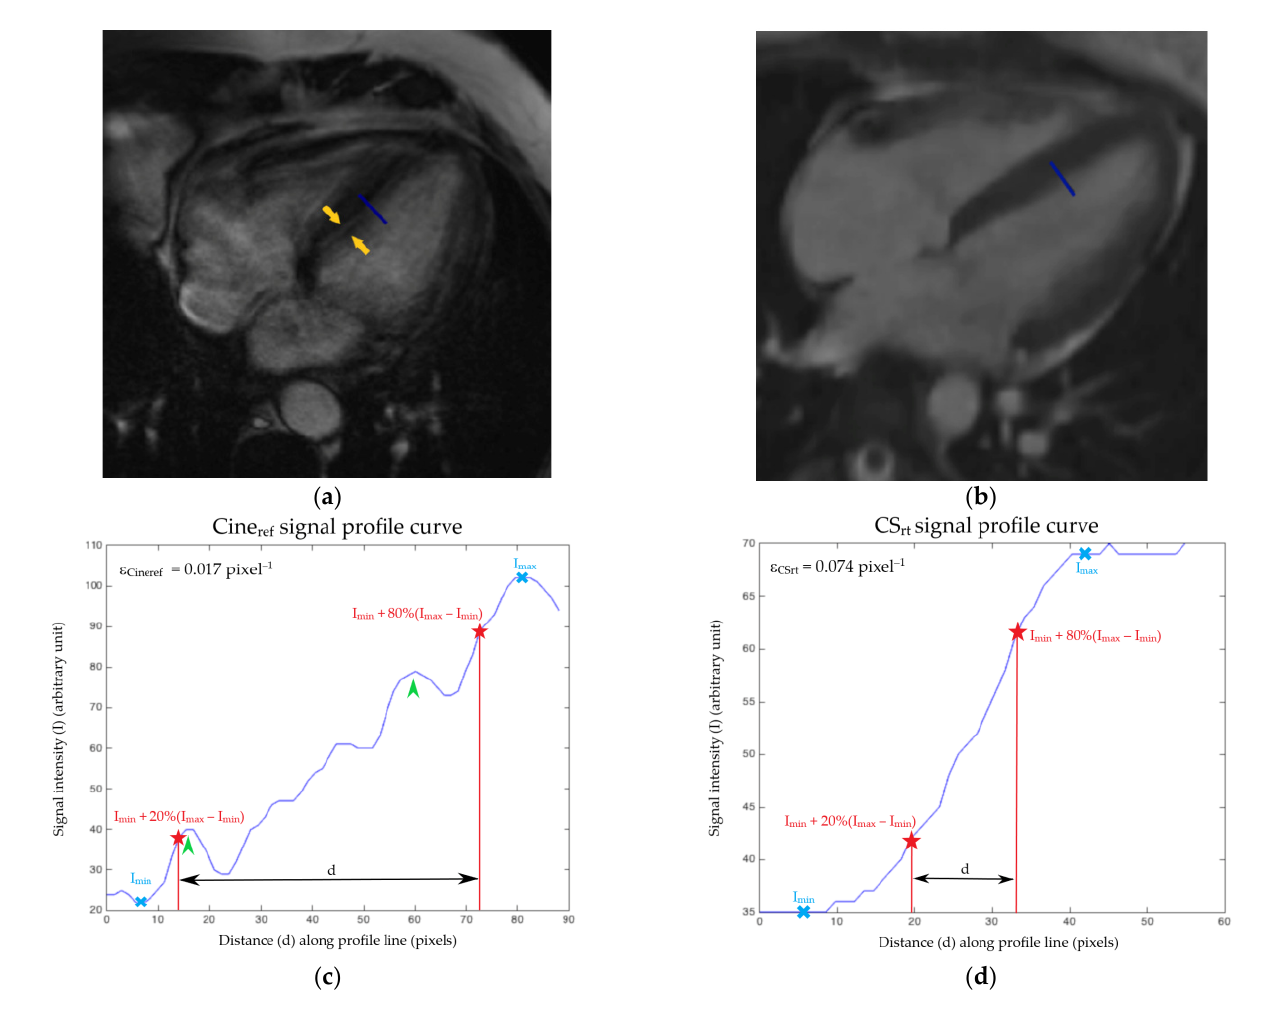
Figure 1. Example of edge sharpness assessment at end-diastole for a 56-year-old male patient suffering from atrial fibrillation. The same four-chamber view at end-diastole is acquired with ( a ) the Cine ref sequence and ( b ) the CS rt sequence. An orthogonal profile line was drawn at mid-cavity across the border between the septal myocardium and the left ventricular blood pool (blue line) on a four-chamber view. It provided intensity profiles (blue curves) along the line for ( c ) Cine ref and ( d ) CS rt cine. The edge sharpness was the inverse of the distance d (in pixels) between the positions corresponding to 20% and 80% (red stars) of the difference between the maximum and minimum signal intensities (blue crosses). The edge sharpness was expressed in pixel − 1 . This measurement was performed at end-diastole and end-systole for both sequences. Note that the peaks (arrows heads) added to the Cine ref signal profile curve ( c ) correspond to the doubling of the interventricular septum border (arrows) on the cine view ( a ). The same assessment was performed on both sequences at end-diastole and end-systole for the 71 enrolled patients. Abbreviations: Cine ref , reference segmented cine; CS rt , real-time compressed sensing cine; ε Cineref , edge sharpness measured on Cine ref sequence; ε CSrt , edge sharpness measured on CS rt cine; I, signal intensity; I min , minimal signal intensity; I max , maximal signal intensity; d, distance along the profile line.